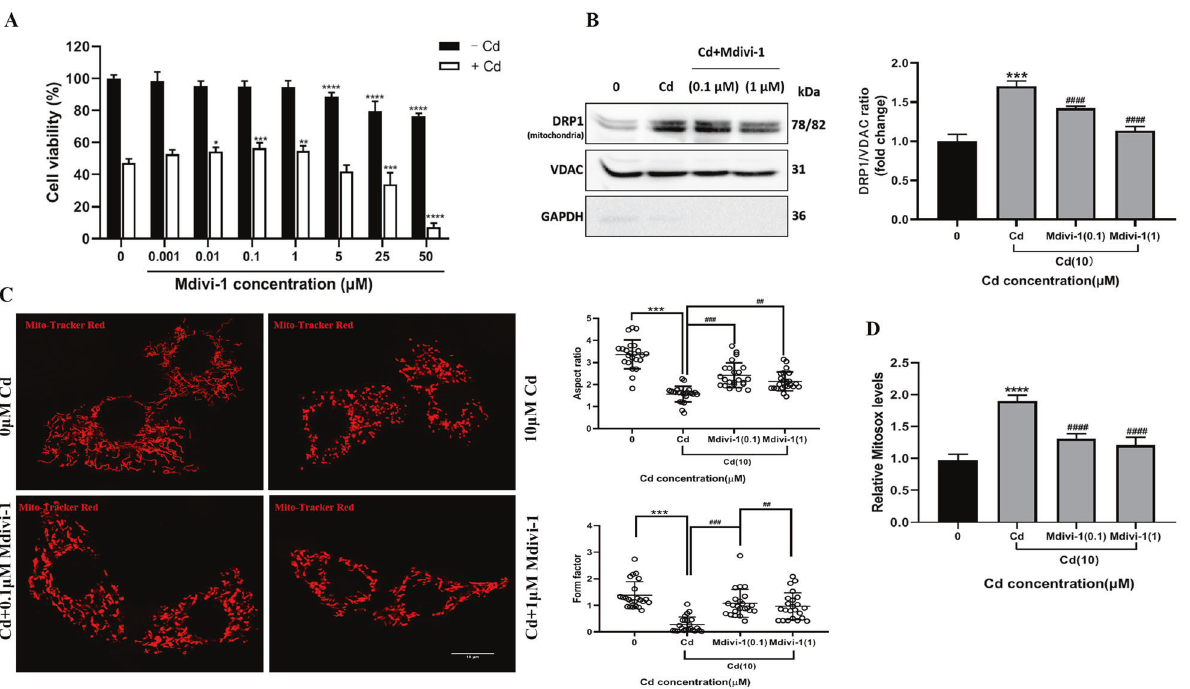
Fig. 6 The DRP1 inhibitor Mdivi-1 protected mitochondrial damage caused by cadmium. A TM3 cells were pretreated with a range of Mdivi-1 concentrations, followed by exposure to 10 μ M Cd for 24 h and the cell viability was measured by CCK-8 assays. B The effect of Mdivi-1 on the mitochondrial location of DRP1 was determined by Western blot. VDAC and GAPDH were used as internal references for mitochondrial and cytosolic fractions, respectively. C The effect of Mdivi-1 on cadmium-induced mitochondrial deformation was analyzed by MitoTracker Red staining, and the aspect ratio and form factor were assessed. D Measurement of mitochondrial ROS levels. Data represent the mean±SD for at least three independent experiments (** P < 0.01, *** P < 0.001, **** P < 0.0001 vs. control; #### P < 0.0001 vs.